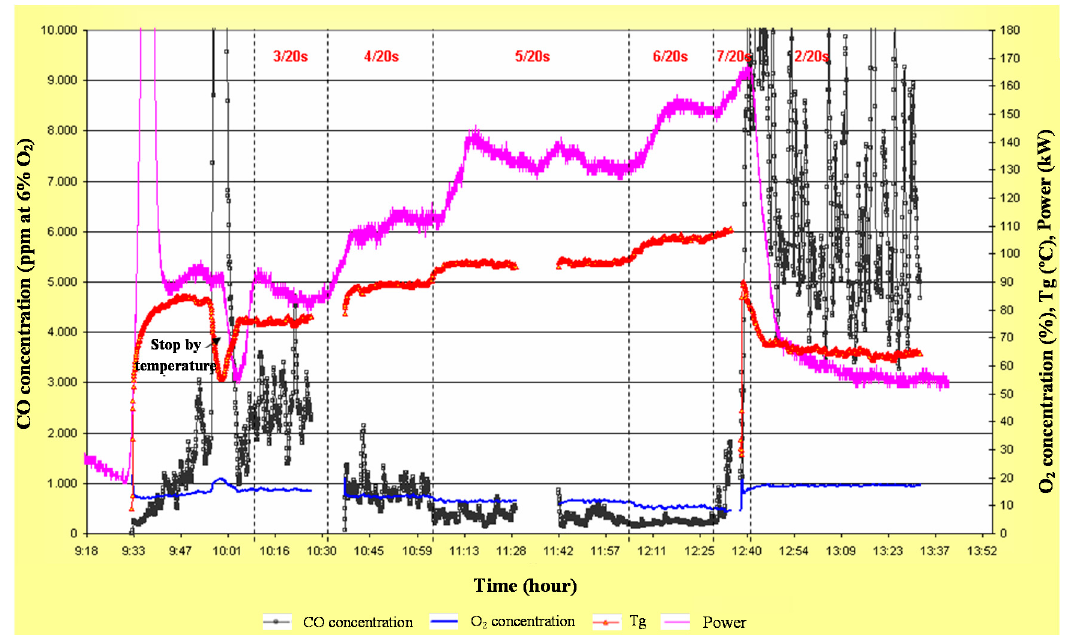
Figure 1. Evolution of CO emissions corrected to 6% O 2 , O 2 concentration, exhaust gas temperature (Tg), and power during combustion tests with pellets from almond tree.